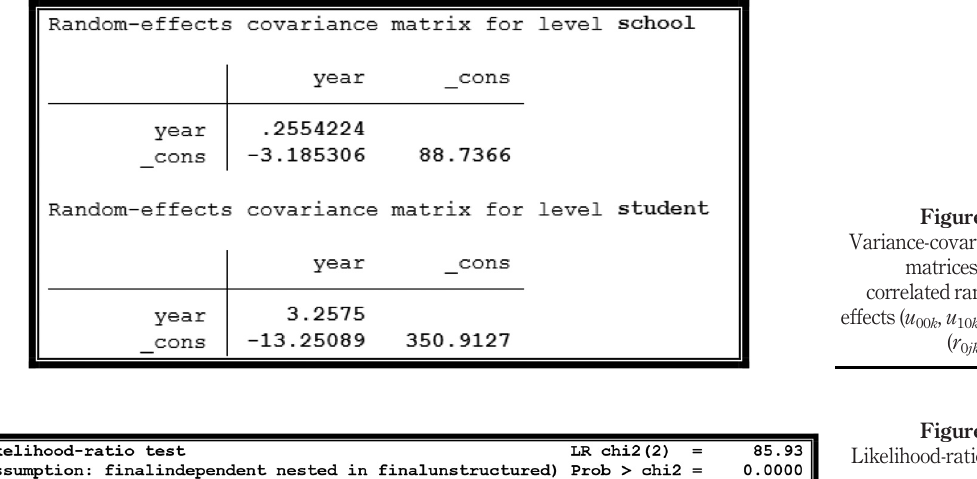
Figure 15. Likelihood-ratio